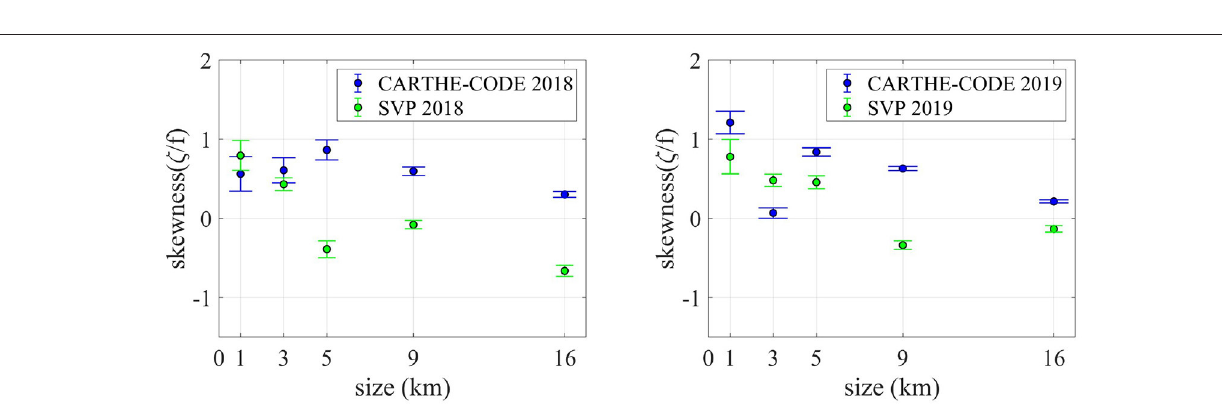
FIGURE 9 | Scale dependence of vorticity skewness for experiments 2018 (left) and 2019 (right) for the surface drifters (CARTHE and CODE) in blue and 15 m drifters (SVP) in